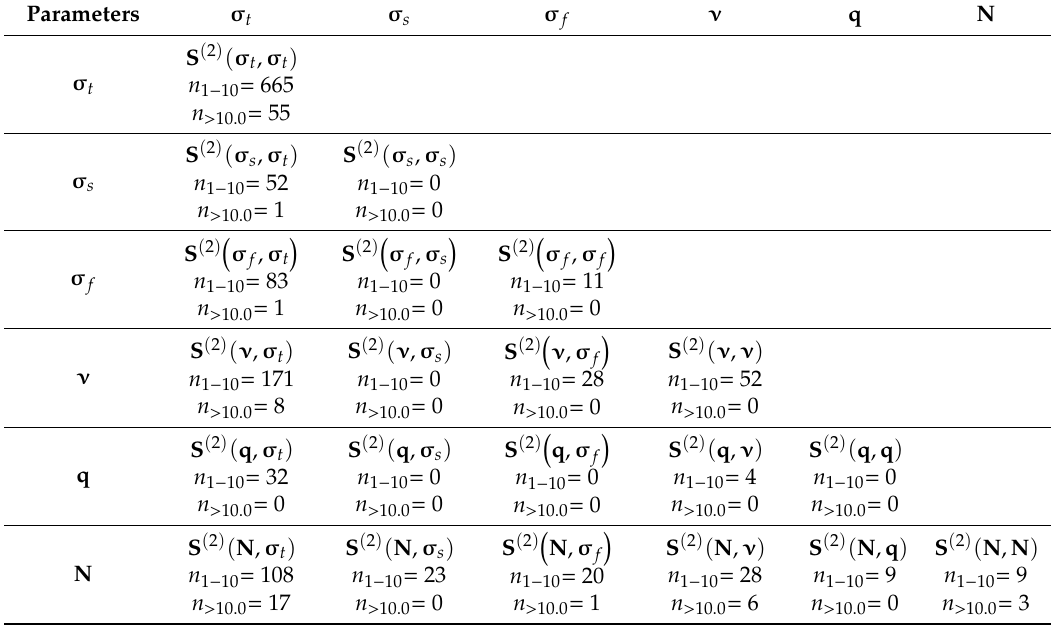
Table 8. Summary of the large 2nd-order relative sensitivities for the PERP